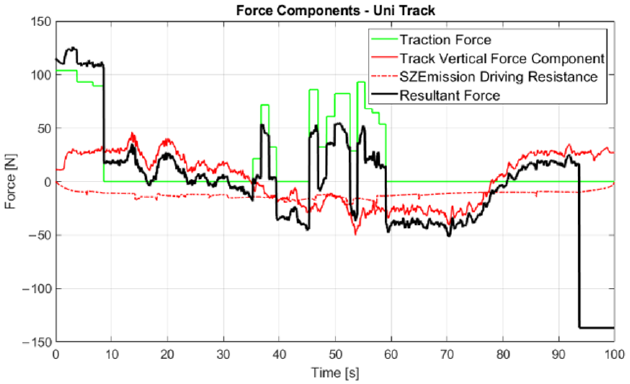
Figure 14. The resultant force components of the driving strategy on the London Track by TRQ